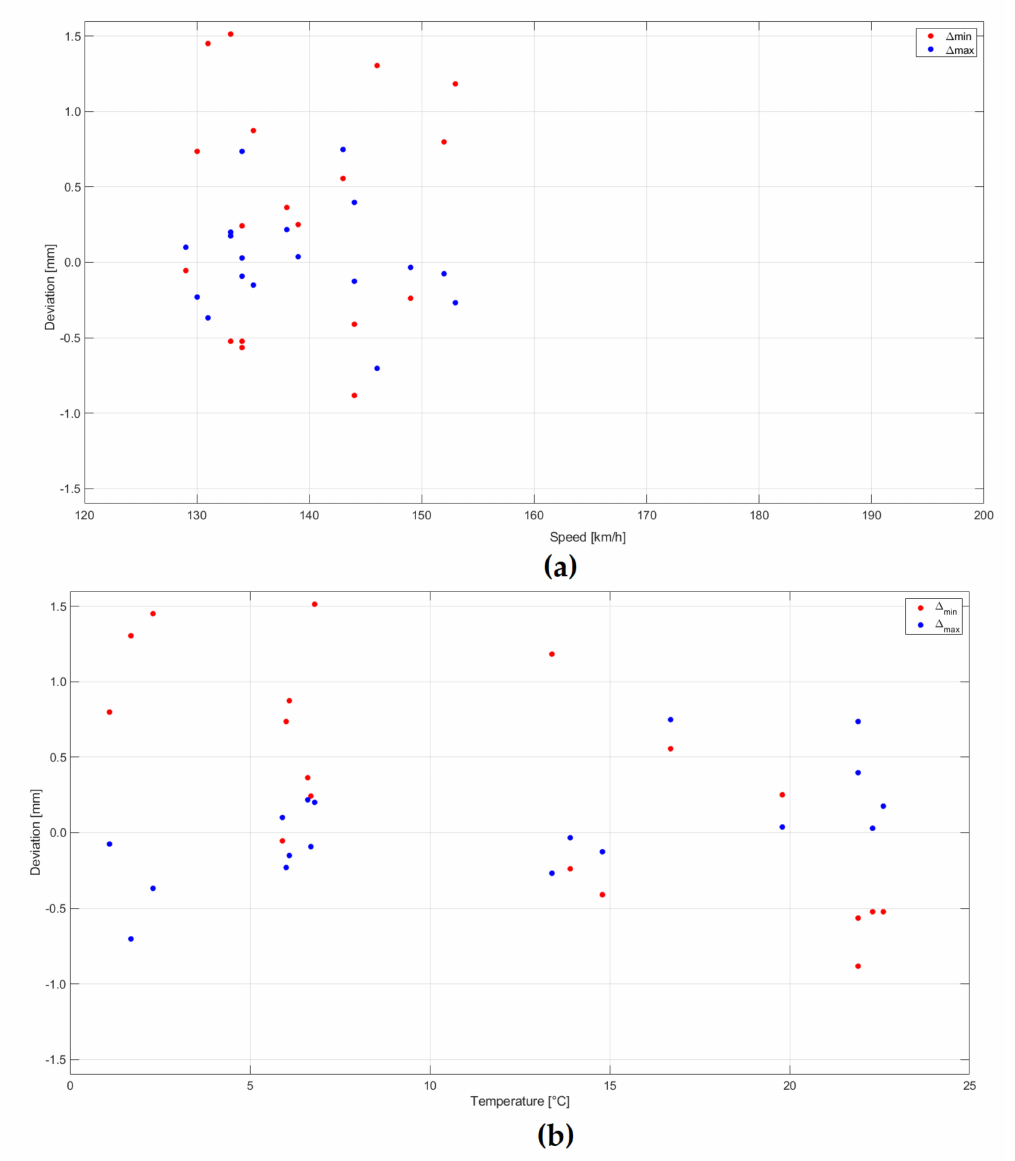
Figure 15. Analysis of the distribution of the measurement result deviation of the extreme values from the reference measurements for separate locomotive (EP09) and cars passages: ( a ) Depending on train speed and ( b ) air